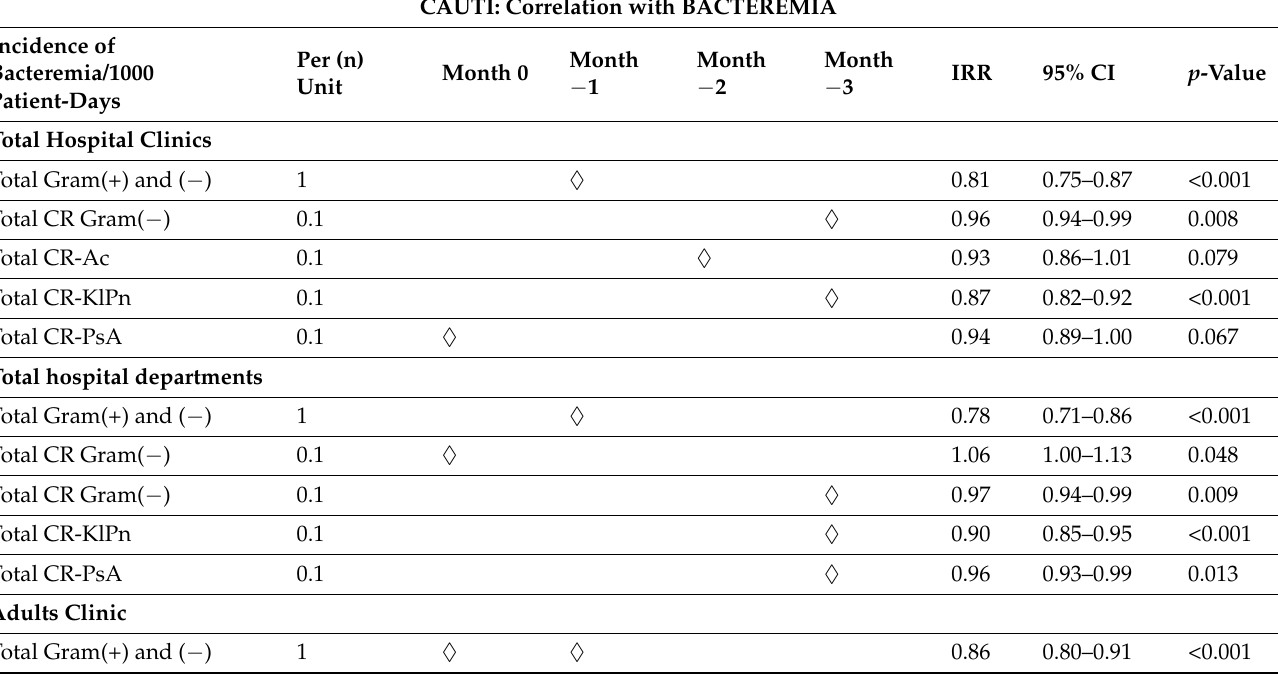
Table 5. Correlation of CAUTI and incidence of bacteremia in a hospital from January 2013 to December